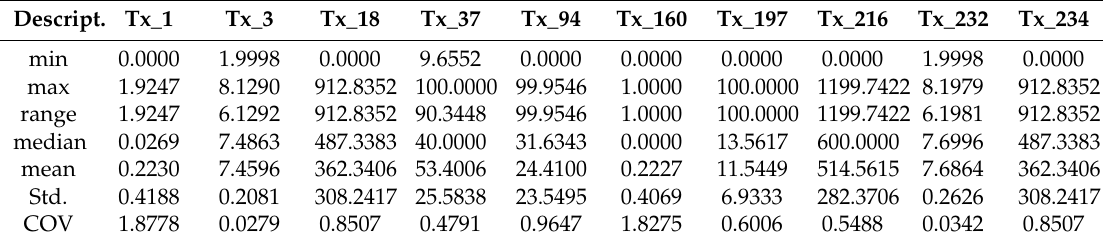
Table 1. Descriptive statistics of some of the SCADA data used for the analysis (Std.: Standard deviation, COV: Coefficient of Variation).